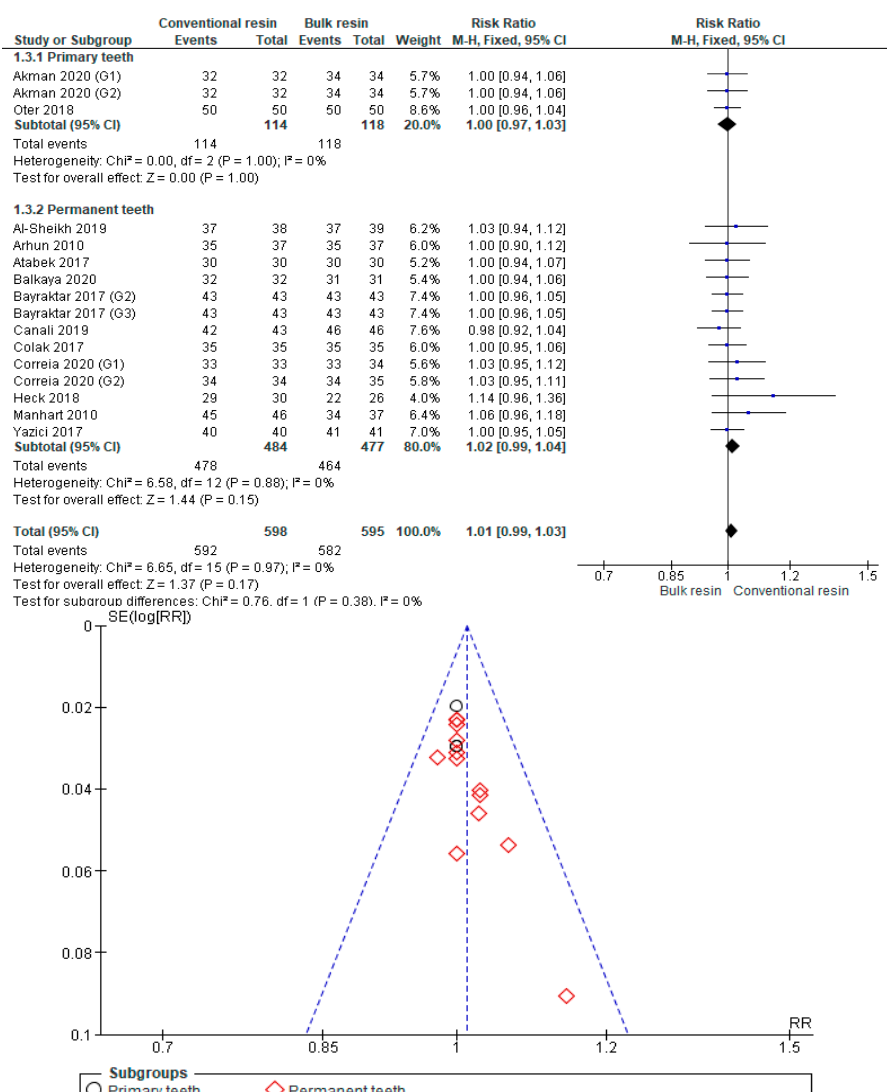
Figure A3. Absence of Fractures: Conventional Resin versus Bulk Resin According to Type of Teething.